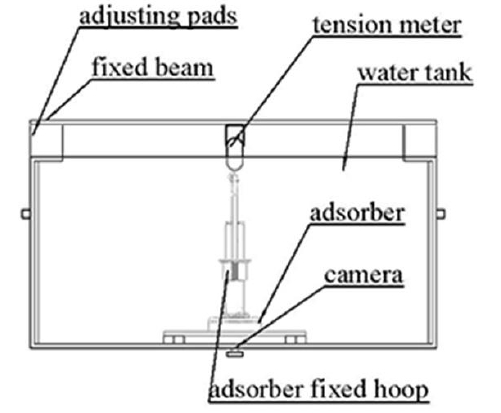
Figure 8. Test scheme for the absorber.